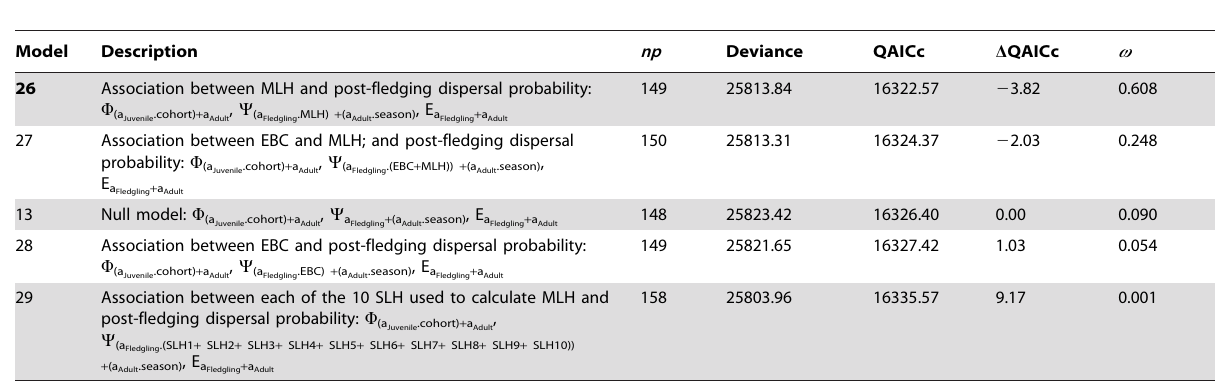
Table 2. Model selection for models evaluating an association between the life history trait of post-fledging dispersal propensity and the individual covariates of microsatellite multilocus heterozygosity (MLH) and early body condition (EBC).